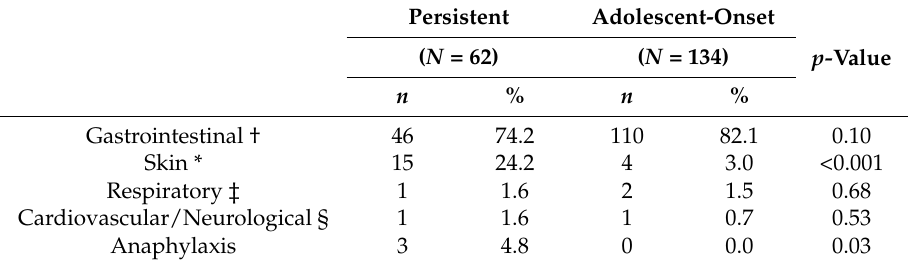
Table 4. Types of parent-reported milk-related symptoms, immediately following milk consumption at age 16 years amongst adolescents with persistent vs. adolescent-onset milk-related symptoms. Persistent